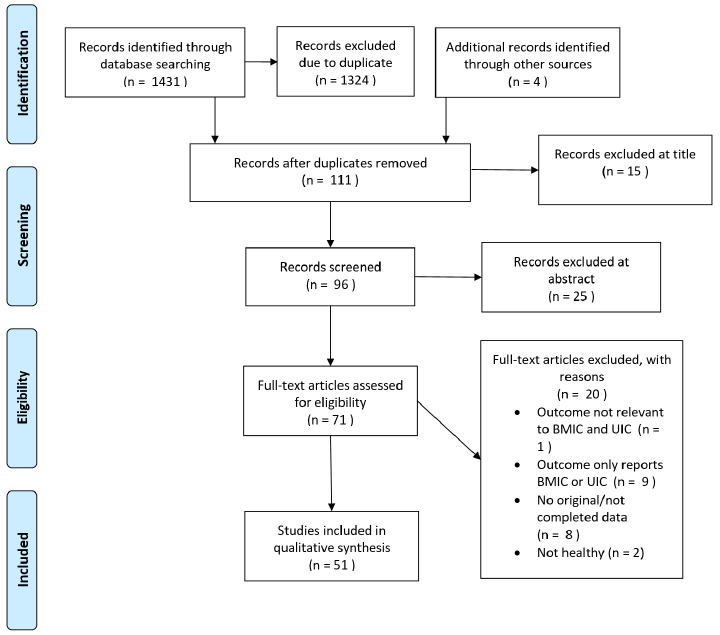
Figure 1. PRISMA 2009 Flow Diagram. Adapted from Moher et al. [13].